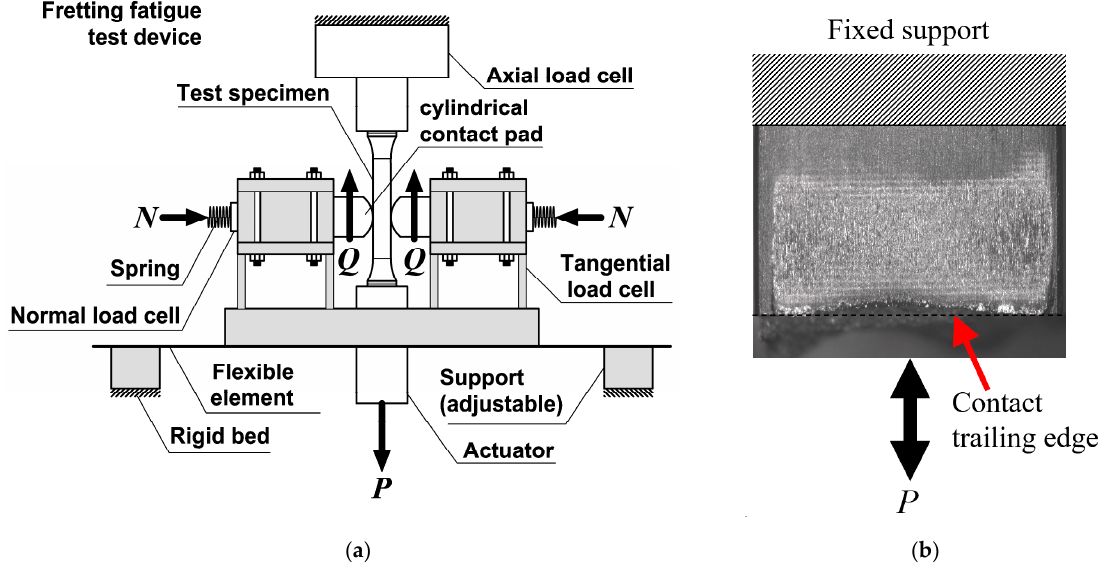
Figure 1. ( a ) Scheme for the device used in the fretting-fatigue tests; ( b ) sample fretting scar obtained in these tests showing where fretting cracks appear.